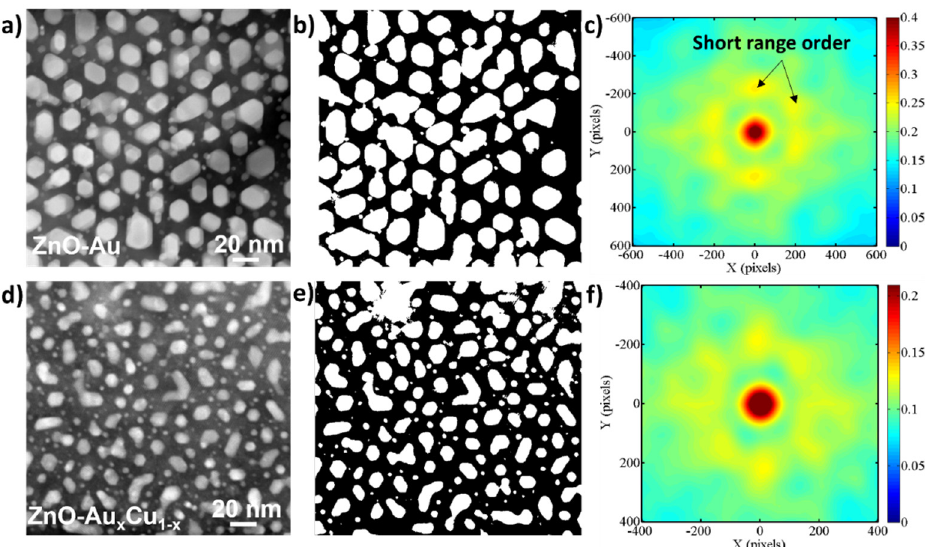
Figure 5. Correlation function. ( a ) STEM plan view of ZnO-Au. ( b ) Binarized image of plan-view ZnO-Au in ( a ). ( c ) Correlation function of plan-view in ( a ). ( d ) STEM plan view of ZnO-Au x Cu 1 − x . ( e ) Binarized image of plan view ZnO-Au x Cu 1 − x in ( d ). ( f ) Correlation function of ZnO-Au x Cu 1 − x .